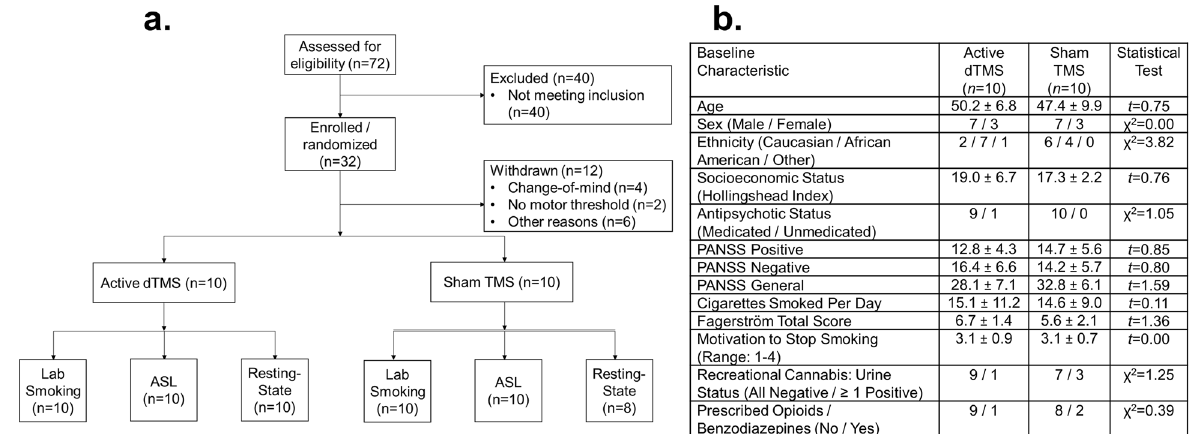
Fig. 1 Study participants. a Flow diagram for the trial. ASL = arterial spin labeling. b Demographics of patients who completed the study. For b , numbers are frequencies or M ± SD. dTMS = deep repetitive transcranial magnetic stimulation, PANSS = Positive and Negative Syndrome Scale. For additional description of the Fagerström scale, motivation to stop smoking, and cigarettes smoked per day (the latter assessed with a Timeline Follow-Back calendar), see the Supplement. Socioeconomic status was measured with the Hollingshead Index 66 . No statistical tests showed signi fi cant differences between the treatment groups.